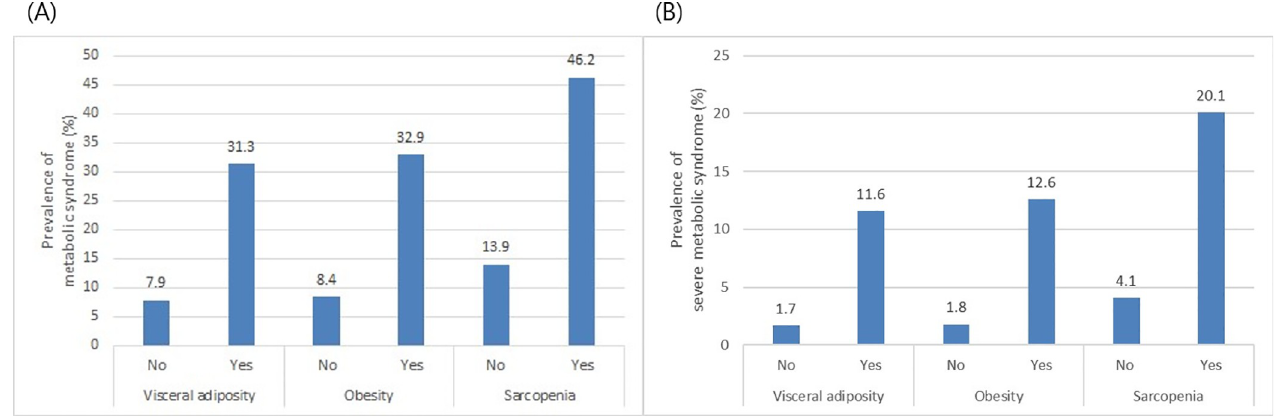
Fig 2. (A) The prevalence of MS in subjects with obesity, visceral adiposity, or sarcopenia was higher than that in subjects without these parameters (P < 0.001 for all). (B) The prevalence of severe MS in subjects with obesity, visceral adiposity, or sarcopenia was higher than that in subjects without them (P < 0.001 for all). MS, metabolic